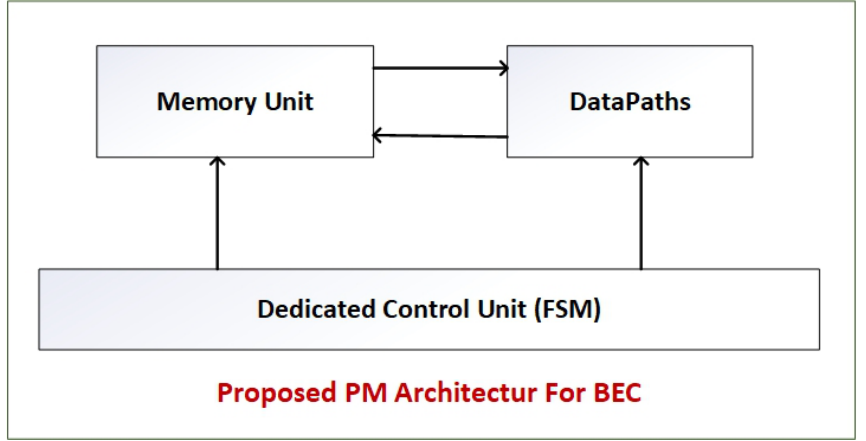
Figure 1. Proposed architecture: Simplified